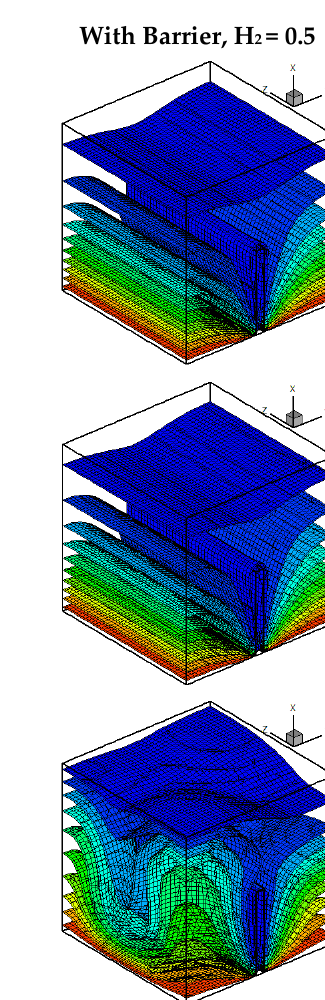
Figure 7. Temperature iso-surfaces in the building for different Ra, effect of two barriers’ heights for N = 0.